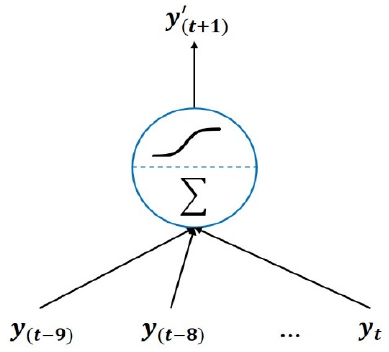
Figure 4. Illustration for LR